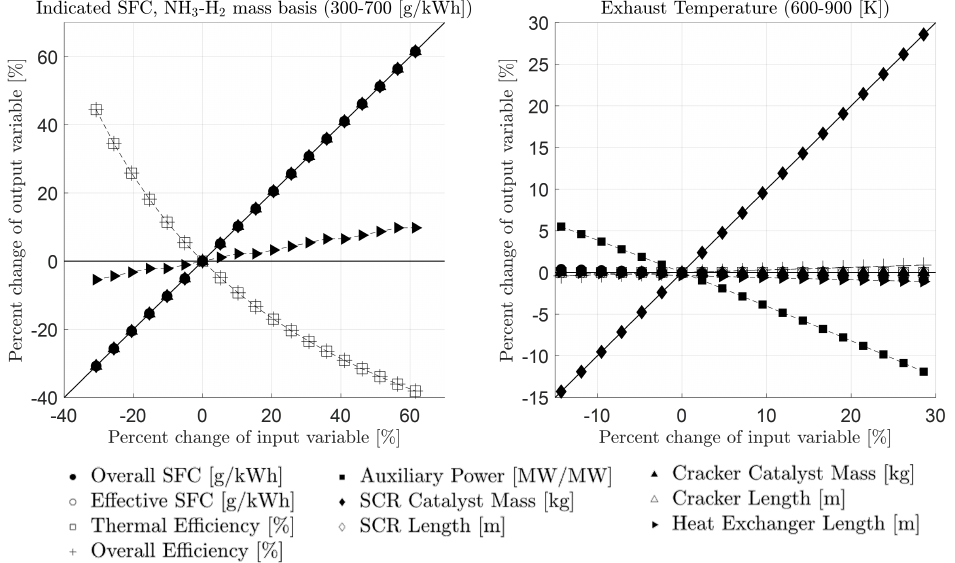
Figure 16. The relative change in relevant output values with respect to the relative change of one input value, in this case, the input indicated SFC on an NH 3 -H 2 mass basis ( left ) and the ICE exhaust temperature ( right ). A horizontal line represents the case that changing the input has no impact on the output variable. A line with a slope of 1.0 represents direct proportionality between changes to the input and changes to the